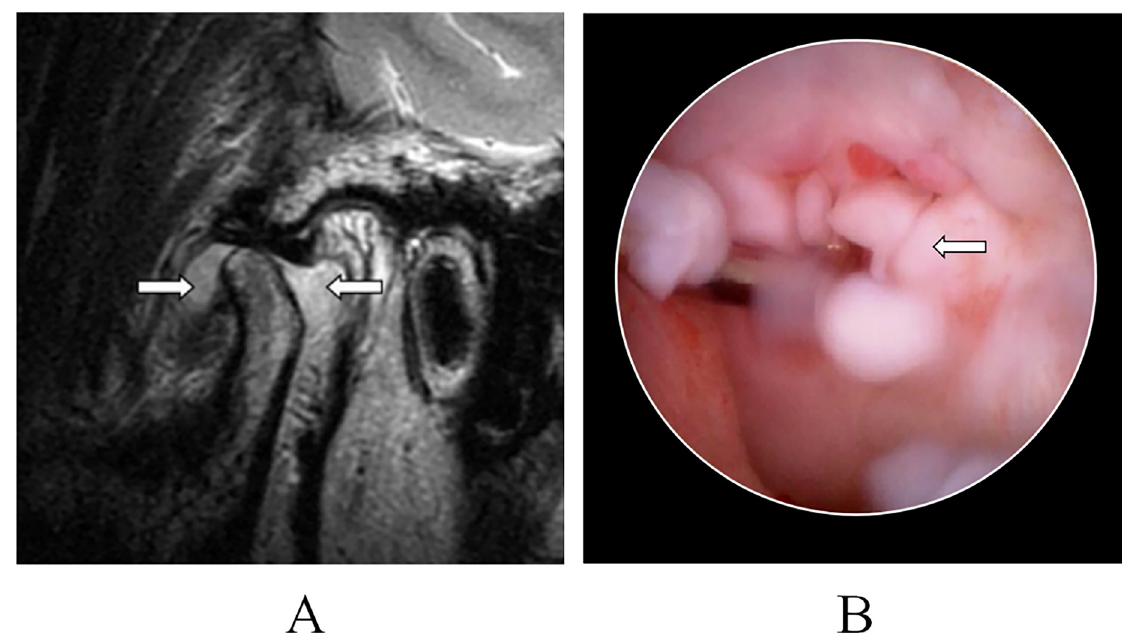
Fig 1. Synovial chondromatosis of temporomandibular joint: Hypointense loose bodies surrounded by hyperintense joint fluid (arrow) was detected on a T2 sequence of MRI, A; Isolated chondrified loose bodies (arrow) was detected during arthroscopic surgery, B.